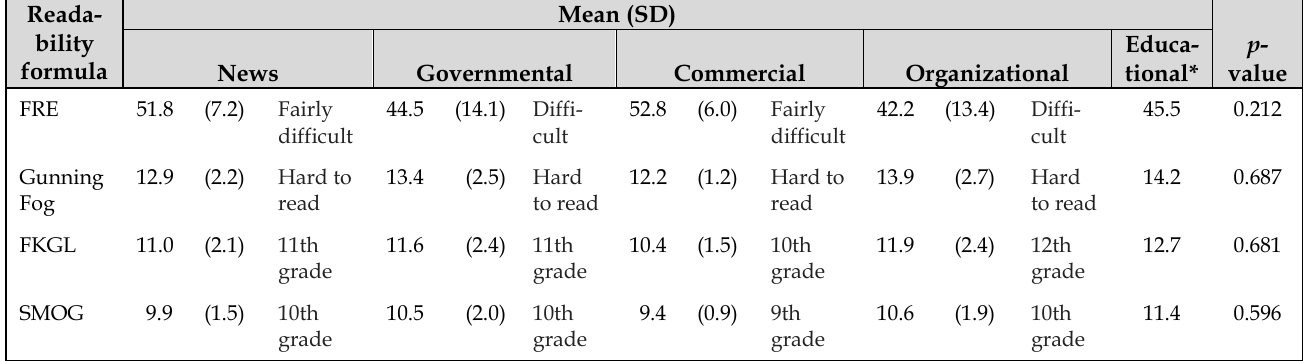
Table 2 Readability scores of websites according to their category Reada-